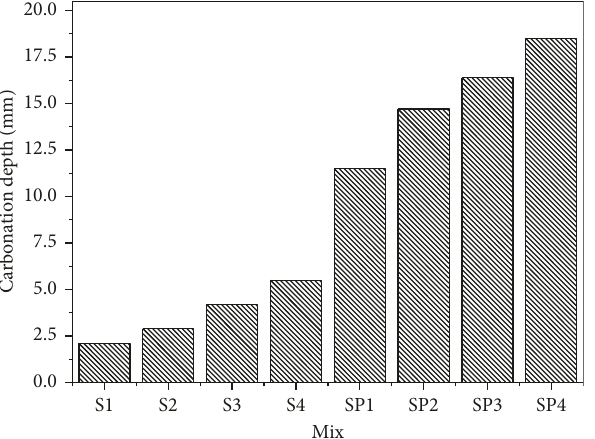
Figure 8: Carbonation depth of steel